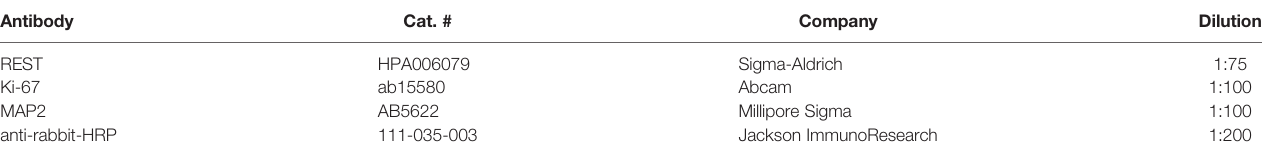
TABLE 1 | Antibodies for IHC. Antibody Cat.